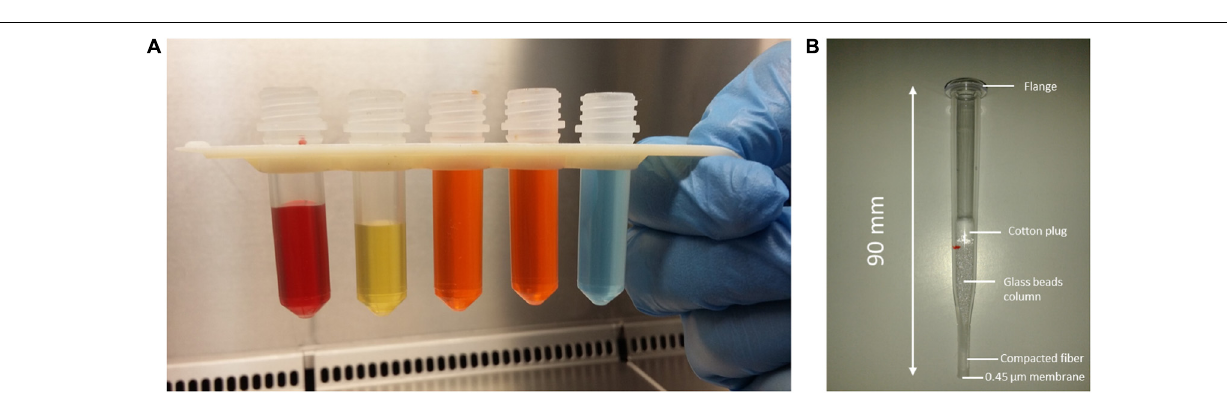
FIGURE 4 | (A) Pre-filled tubes snap into a 3D printed support formed the extraction disposable strip. Colored liquids are used to visualize the volume in each tube. From left to right: red = 1 mL of positive BC; yellow = lysis buffer; orange = wash buffer 1 tubes; and blue = wash buffer 2. (B) Picture of molded assembled polystyrene crystal filter wand pipette used for prototype